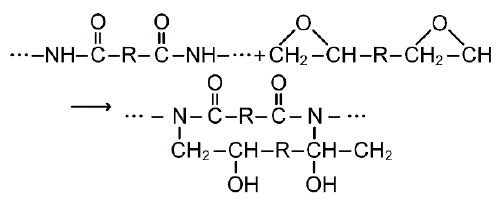
Figure 19. Schematic of the cross-linking reaction.